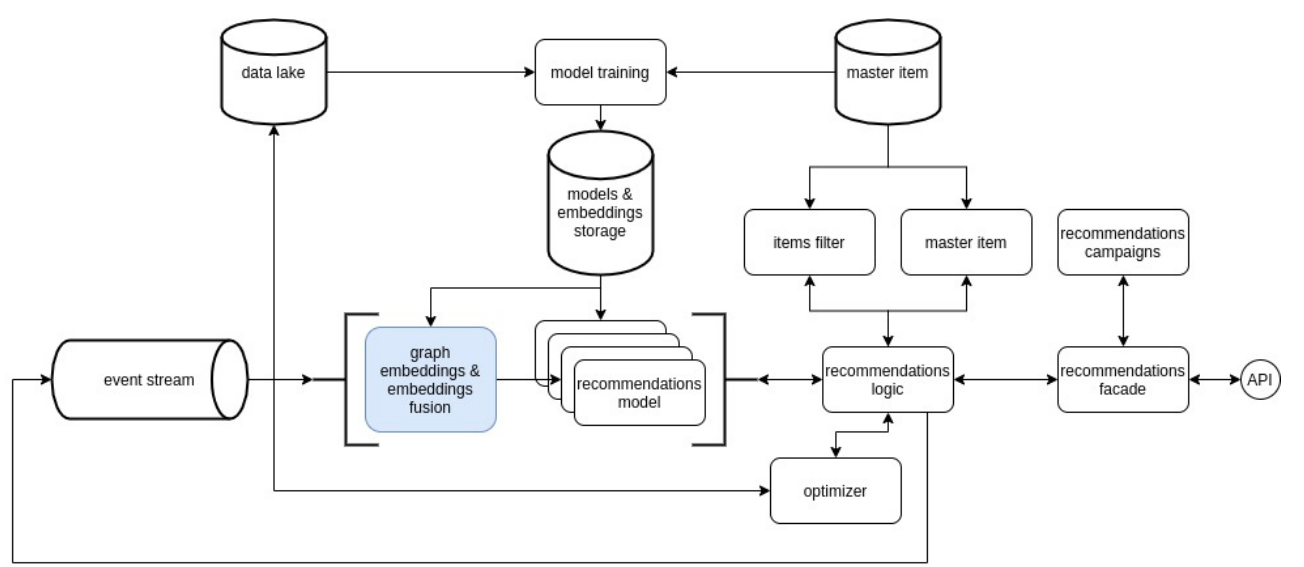
Figure 2. A general architecture of our recommendation